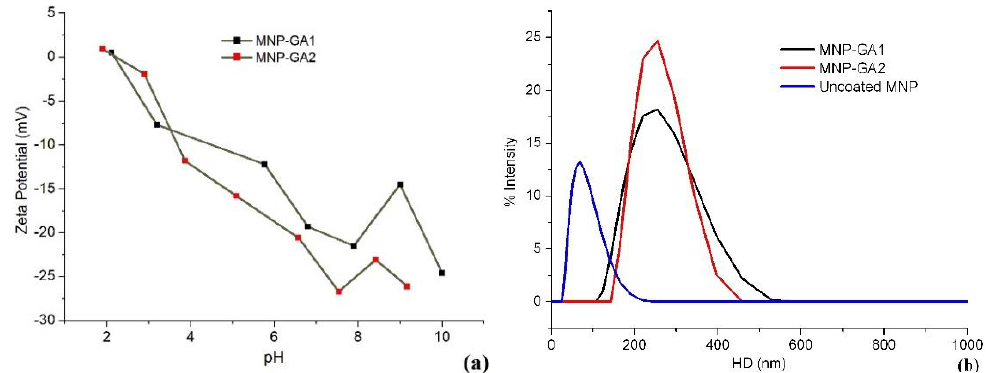
Figure 4. The relative dependence of the temperature on the mass loss of the GA (dark line), MNP- GA1 (blue line), and MNP-GA2 (red line).